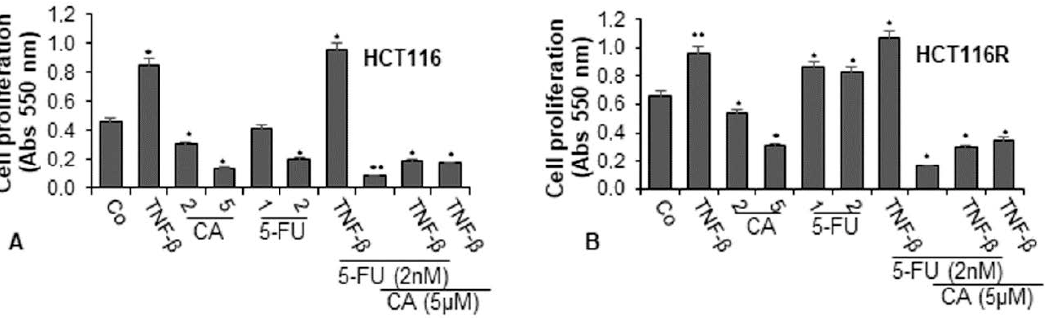
Figure 1. Effects of Calebin A and/or 5-Fluorouracil (5-FU) on TNF- β -promoted cell proliferation in colorectal cancer cells (CRC) cells in the monolayer culture. Serum-starved cultures of HCT116 ( A ) and HCT116R ( B ) cell lines were treated as described in the Materials and Methods section. Cell viability and proliferation were evaluated with the MTT method. All assays were performed at least three times. p < 0.05 (*) and p < 0.01 (**) indicate a significant difference compared to the control group.